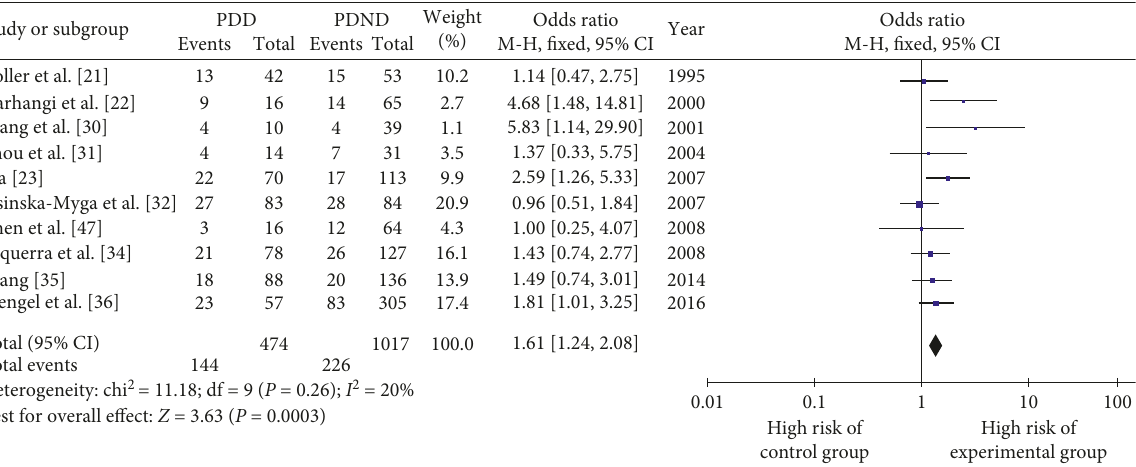
Figure 4: Forest plot for the risk of Parkinson’s disease dementia onset in ε 4+ patients assessed in 10